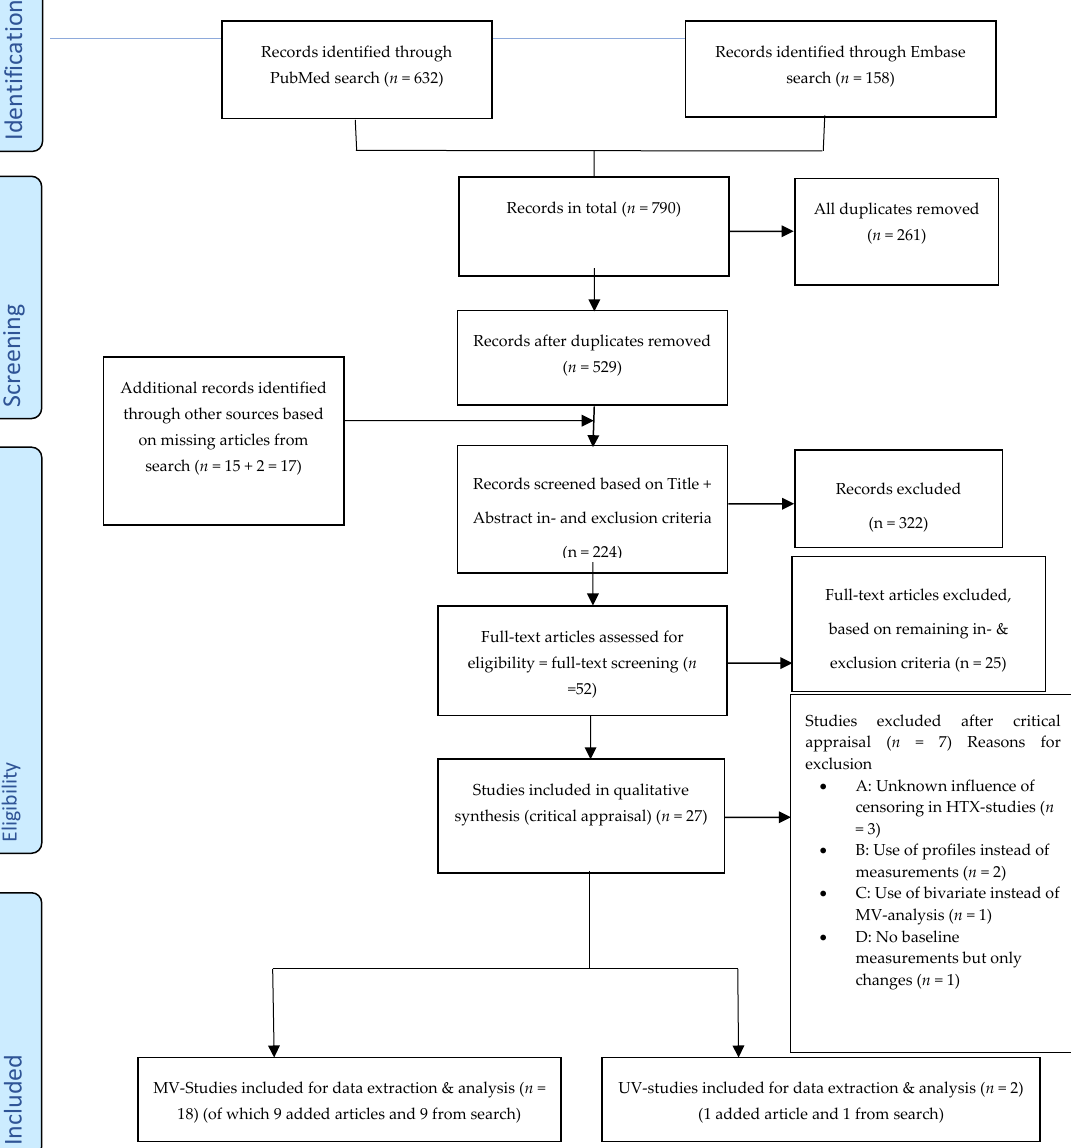
Figure 1. PRISMA flow diagram for selection of studies